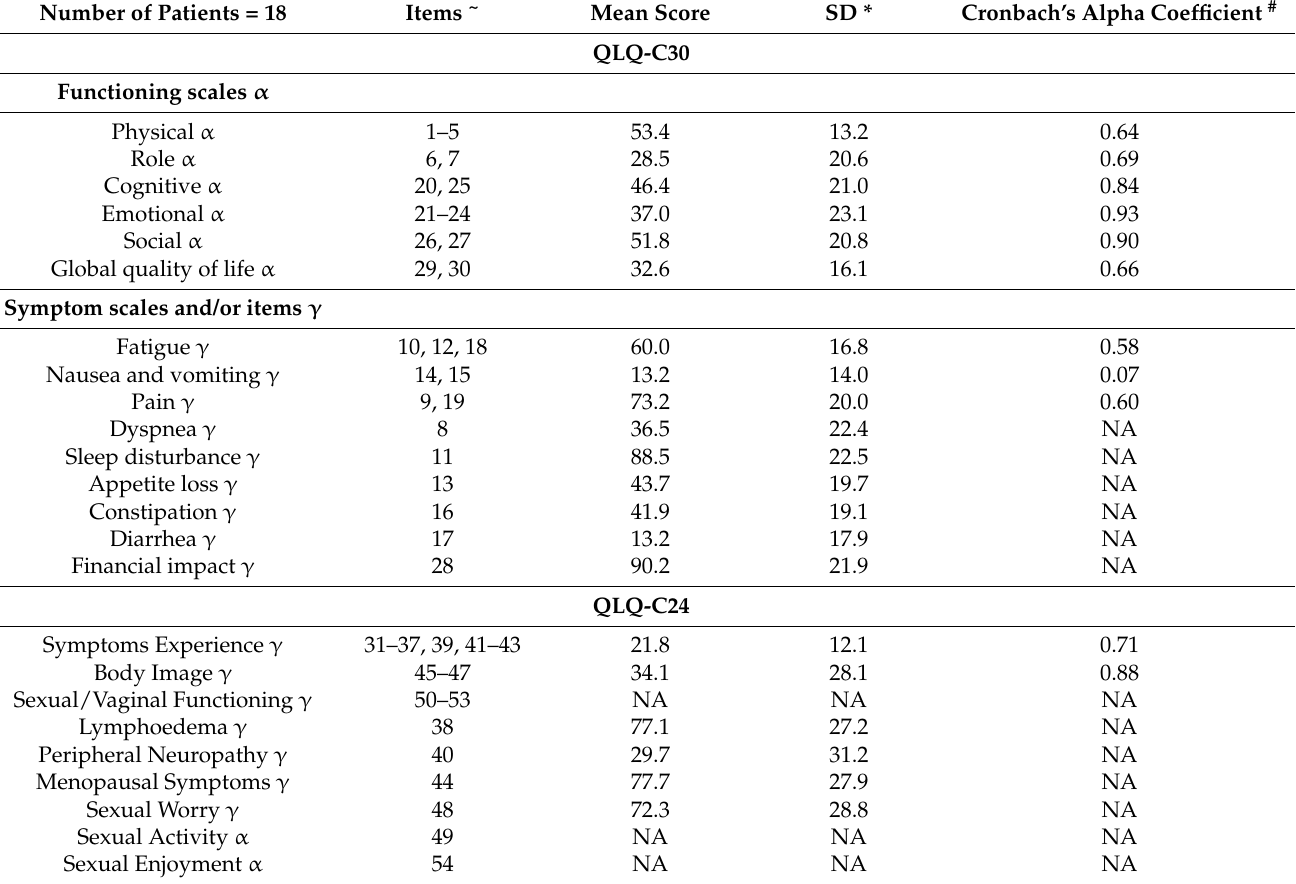
Table 3. The QoL of the 18 patients who answered the EORTC QLQ-C30 and EORTC QLQ-CX24. Number of Patients =